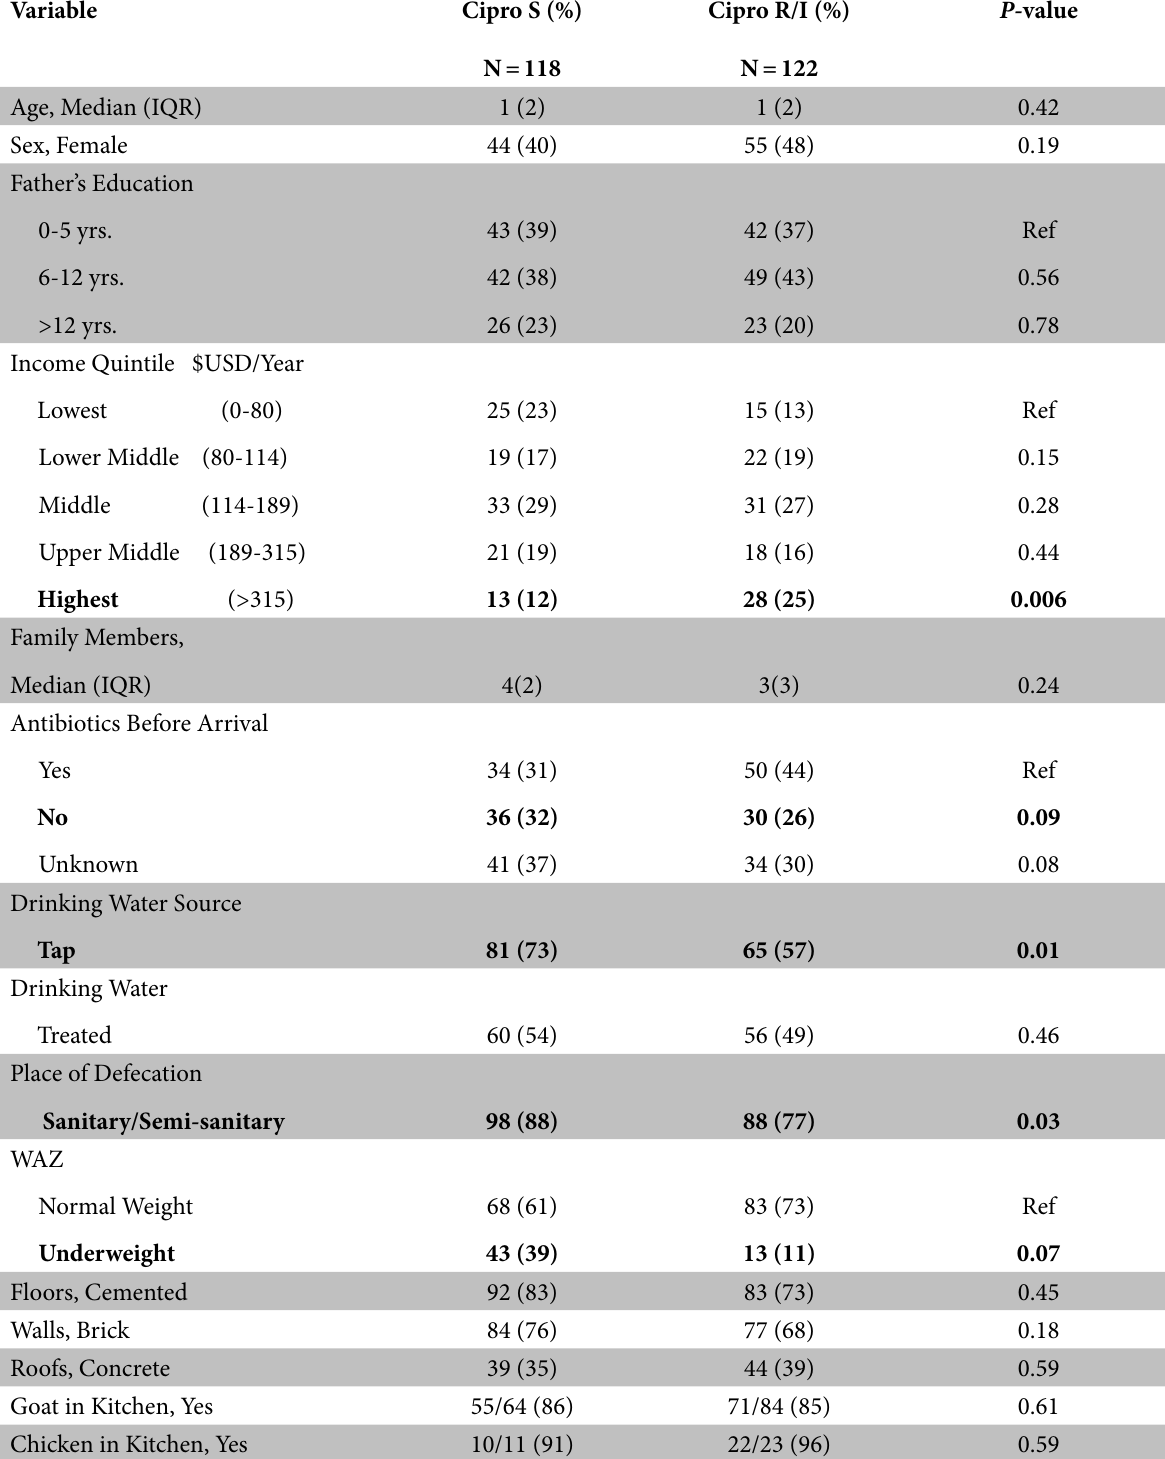
Table 3. Univariate Logistic Regression